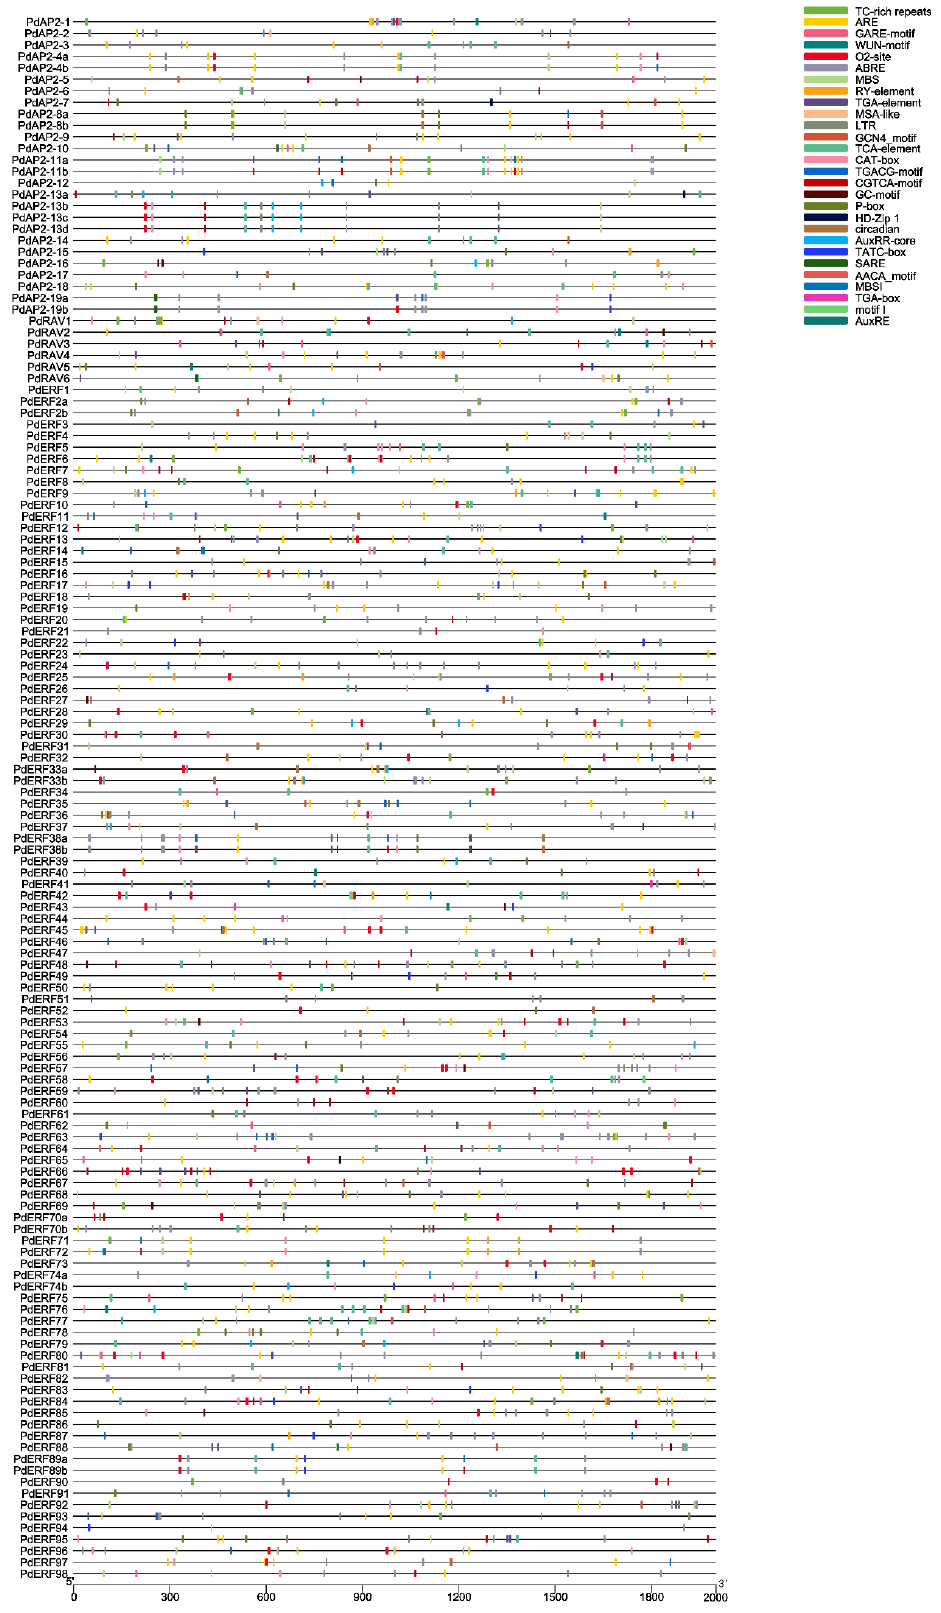
Figure 6. Cis -acting elements in the promoter regions of PdAP2/ERF family members. Each color square represents a cis -element